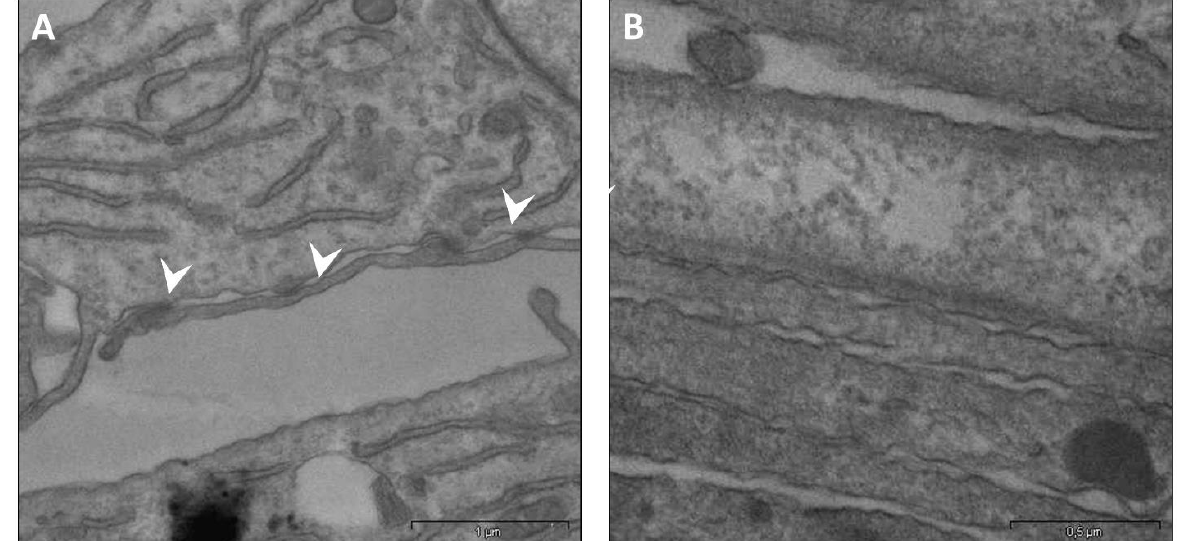
Figure 10. TEM analysis of fibroblasts cultured at unitary gravity or under simulated microgravity for 24 h. The ultrastructure of fibroblasts cultured at unitary gravity ( A ) or under simulated microgravity ( B ) is shown. The arrowheads indicate adherent desmosome-like junctions among plasma membrane protrusions, which were abundant in unitary-gravity-cultured cells ( A ) but could not be observed in samples exposed to simulated microgravity. Indeed, in the latter samples, cells did not form adhesive junctions, even when the cell plasma membranes interacted ( B ).